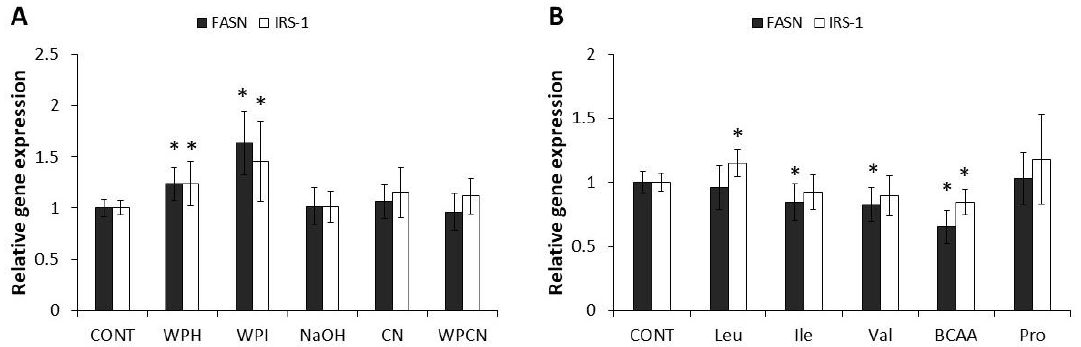
Figure 1. Effect of ( A ) dairy proteins or ( B ) amino acids on mRNA levels of fatty acids synthase ( FASN) and insulin receptor substrate-1 ( IRS-1) gene in HepG2 cells. * Significantly different compared to control ( p < 0.05). CONT: control; WPH: hydrolysate of whey proteins; WPI: isolate of